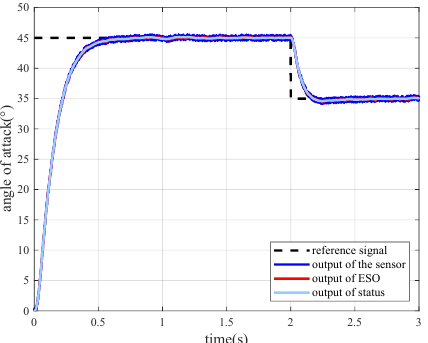
Figure 6. Angle of attack under